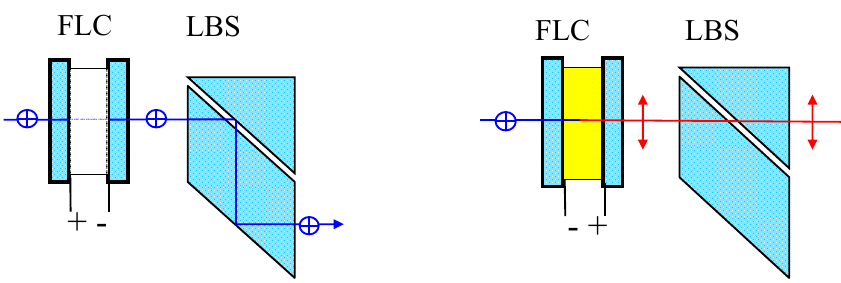
Figure 4. Schematics of possible switching through the ferroelectric liquid crystal (FLC) binary switch